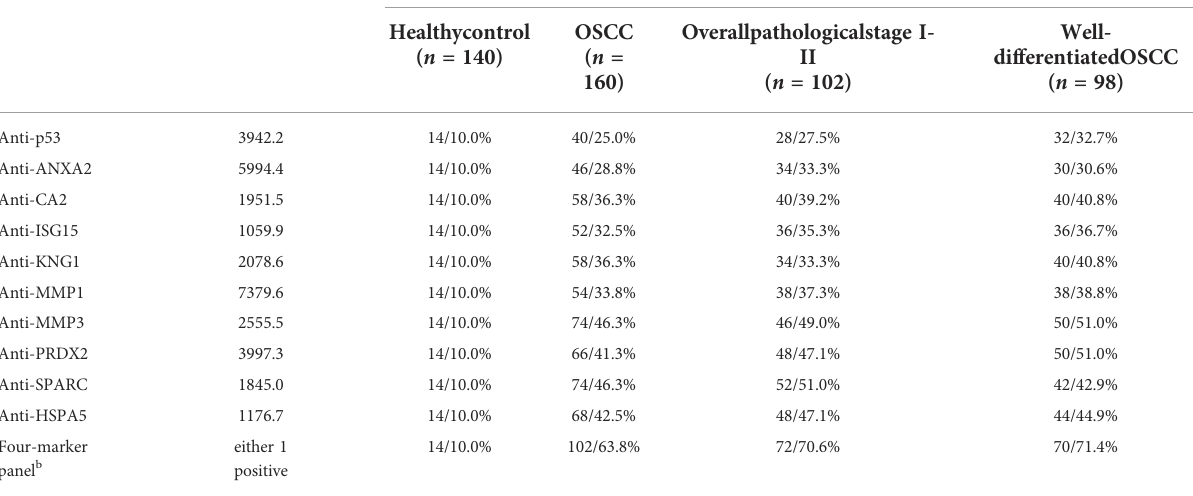
TABLE 3 Sensitivities of salivary auto-Ab biomarkers for OSCC